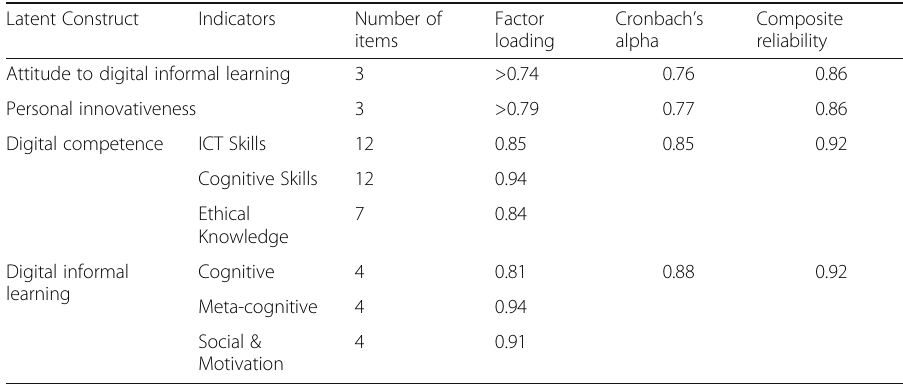
Table 4 Measurement of constructs (with reliabilities) Latent